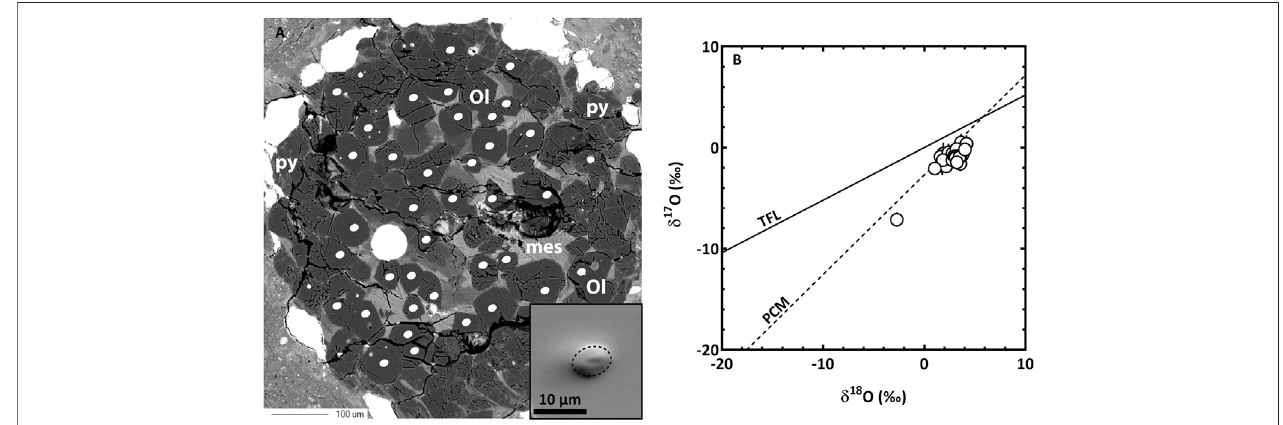
FIGURE 4 | (A) Backscattered electron image of a type I POP chondrule from the primitive meteorite Renazzo. An example of the beam shape obtained with settings 3 is shown in the inset on the lower right of the image. (B) Three-oxygen isotopes diagram of 34 analyses in the olivine grains of the chondrule. Typical uncertainties for δ 18 O and δ 17 O are 0.3 – 0.4 ‰ and 0.4 – 0.6 ‰ respectively (2 σ ). TFL stands for the Terrestrial Fractionation Line (slope ∼ 0.52) and PCM for the Primitive Chondrules Minerals line(slope ∼ 1;Ushikubo et al.,2012).The datawiththe 16 O-richcompositioncorresponds toarelict olivinegrainwhiletheother dataare host olivine grains that crystalized in the melt and equilibrated with the surrounding gas during chondrule formation. Ol (cid:1) olivine, py (cid:1) pyroxene, mes (cid:1) mesostatis.